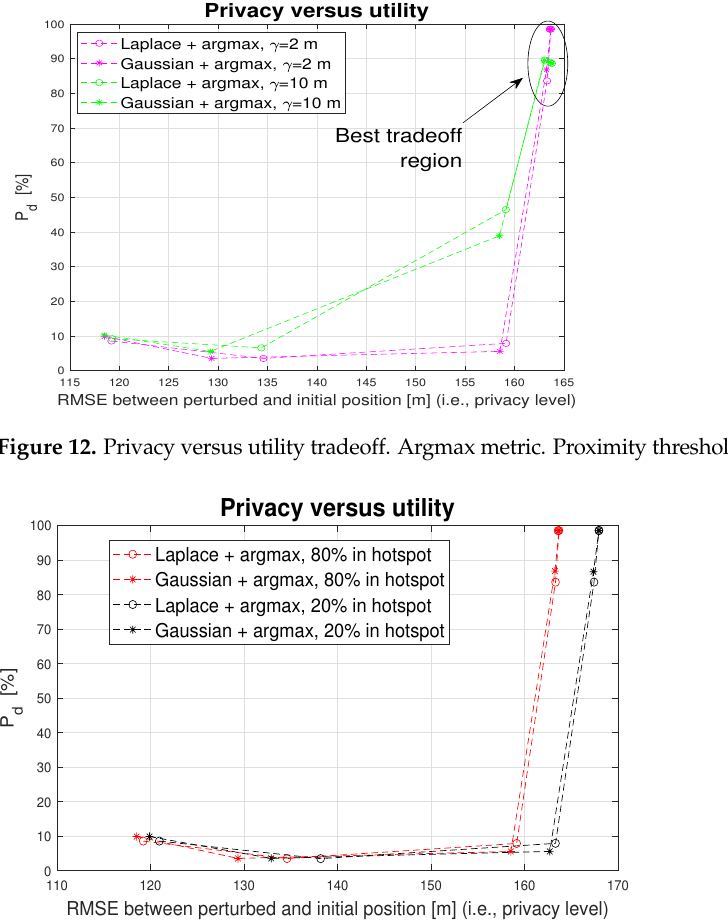
Figure 13. Privacy versus utility tradeoff in the presence of different hotspot distribution of users (80% of users within hostpots versus only 20% of users within the building hotspots). Argmax metric and γ = 2